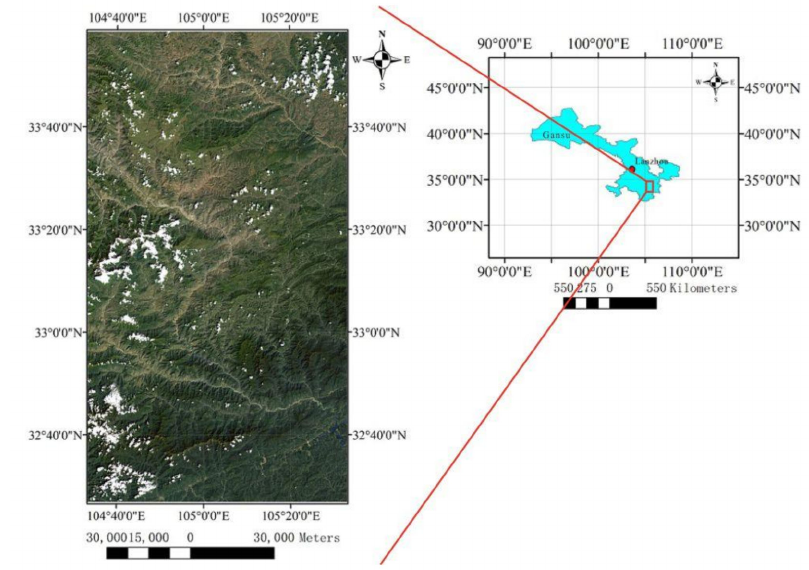
Figure 2. Location of Landsat-8